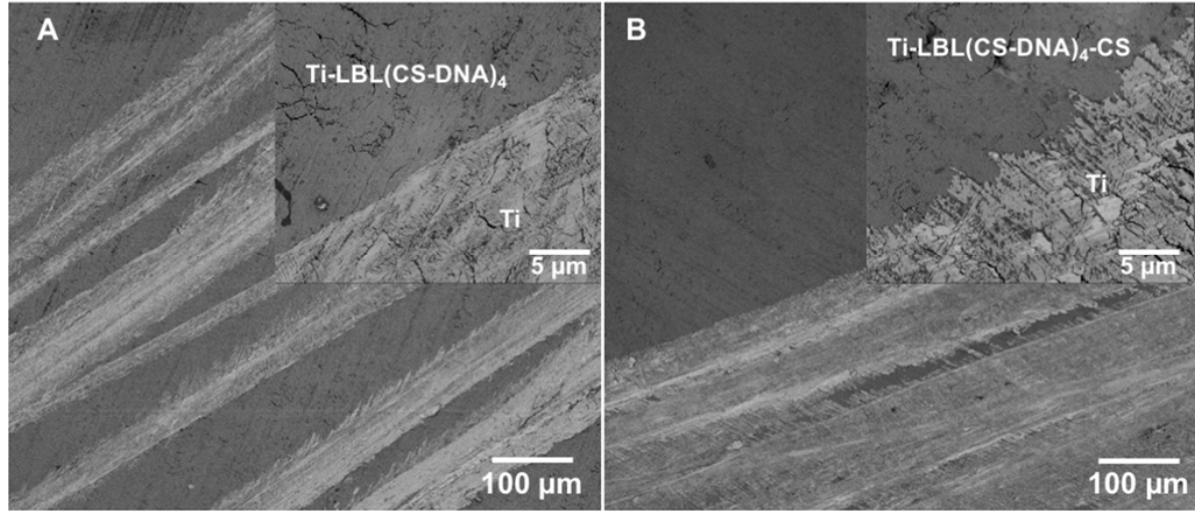
Figure 1. Scanning electron micrographs of multilayer coatings on Ti surfaces. The coating was removed by performing a scratch using a tweezer. ( A ) Representative micrograph comparing Ti-LbL(CS-DNA) 4 coating (dark region) and the uncoated Ti surface (light region). ( B ) Representative micrograph comparing Ti-LbL(CS-DNA) 4 -CS coating (dark region) and the uncoated Ti surface (light region). The insets are high magnification images. The presence of a coating can be clearly differentiated from the uncoated Ti surface at the border where the coating was removed.